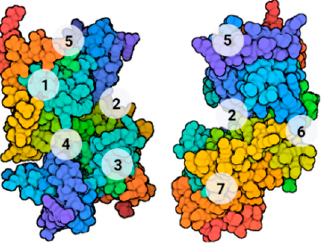
Figure 3. Representation of the seven well-conserved cavities of GSK-3 β (PDB ID: 1Q3D) characterized from Palomo et al. [32] (created with BioRender.com).